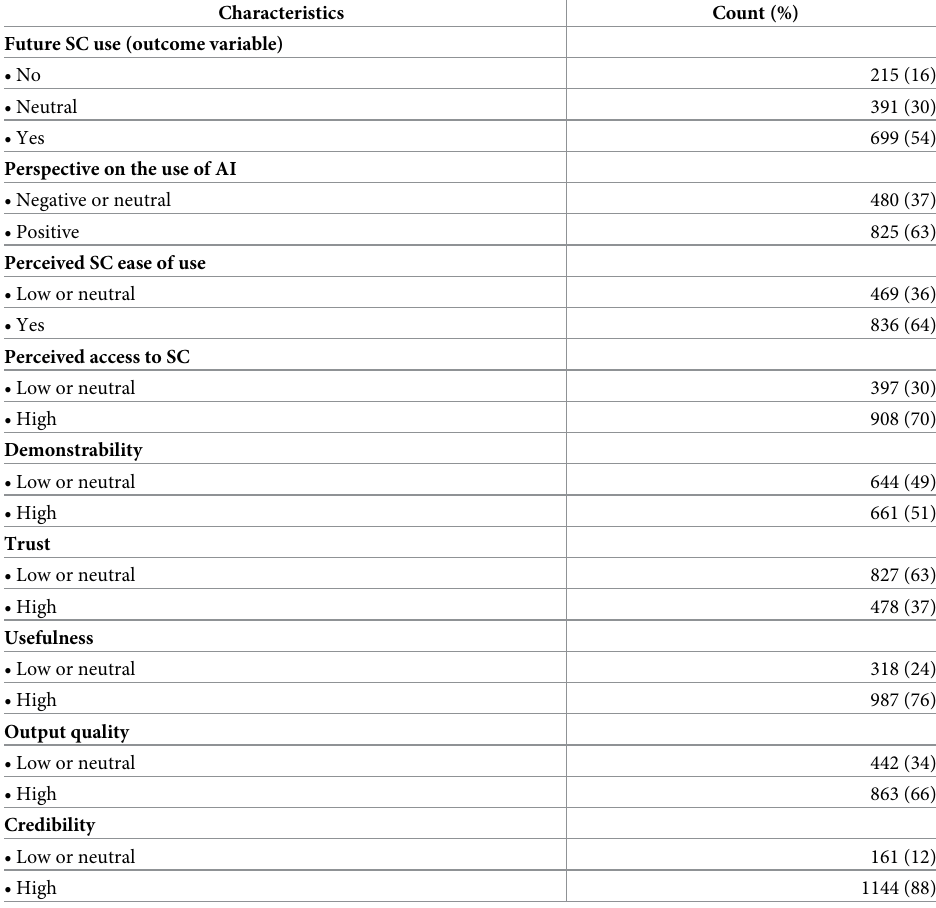
Table 2. Descriptive statistics on the intent to use symptom